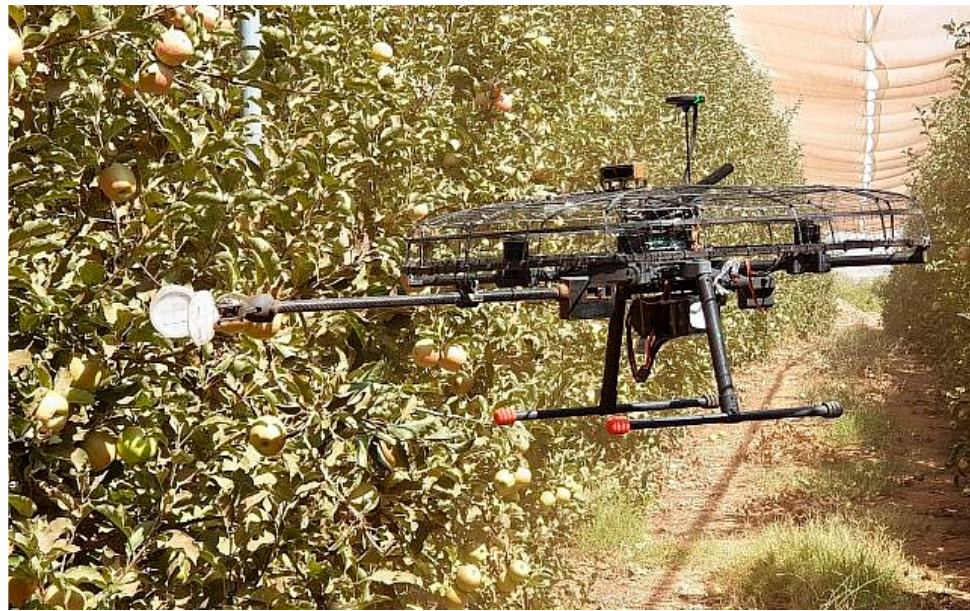
Figure 8. Telev aerial harvesting robot; first prototype [88].